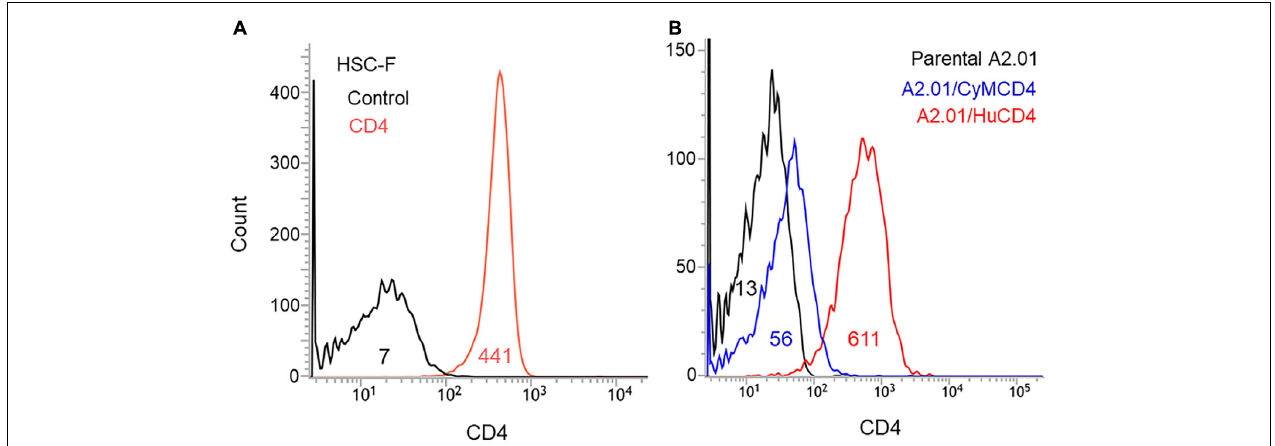
FIGURE 3 | Surface CD4 expression on the cell lines used in this study. Various cell lines were stained with FITC-labeled CD4 antibody, and were subjected to flow cytometry analysis. Numbers in graphs indicate the mean fluorescence intensity of each sample. (A) Analysis of CD4-positive HSC-F cells. Negative control is shown by black line. (B) Analysis of A2.01 cell line and its derivatives. Parental A2.01 (CD4-negative), A2.01/CyMCD4, and A2.01/HuCD4 cells are shown by black, blue, and red lines,